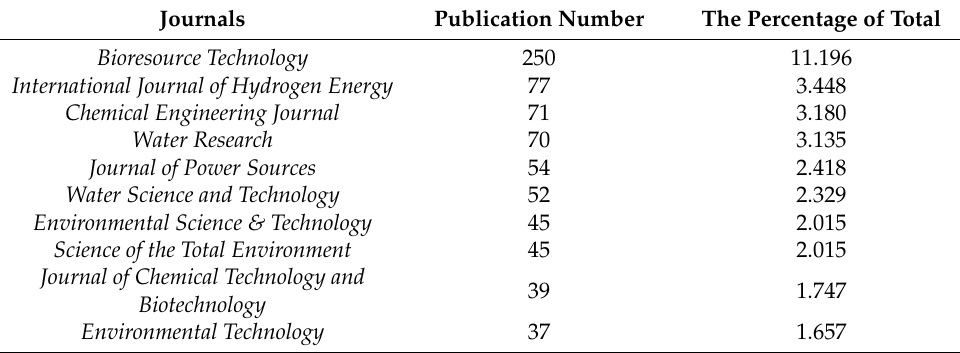
Table 2. The top 10 journals on MFCs in wastewater treatment.